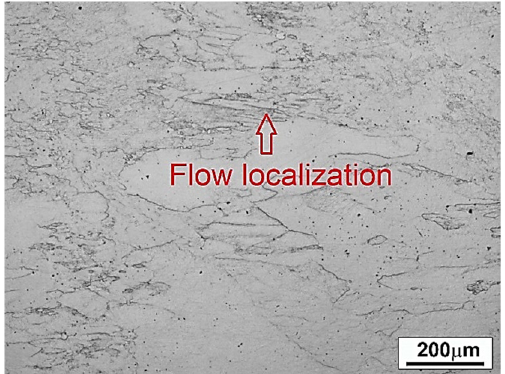
Figure 10. The microstructure of Ti-1023 alloy deformed under thermomechanical parameters corresponding to flow instability area.